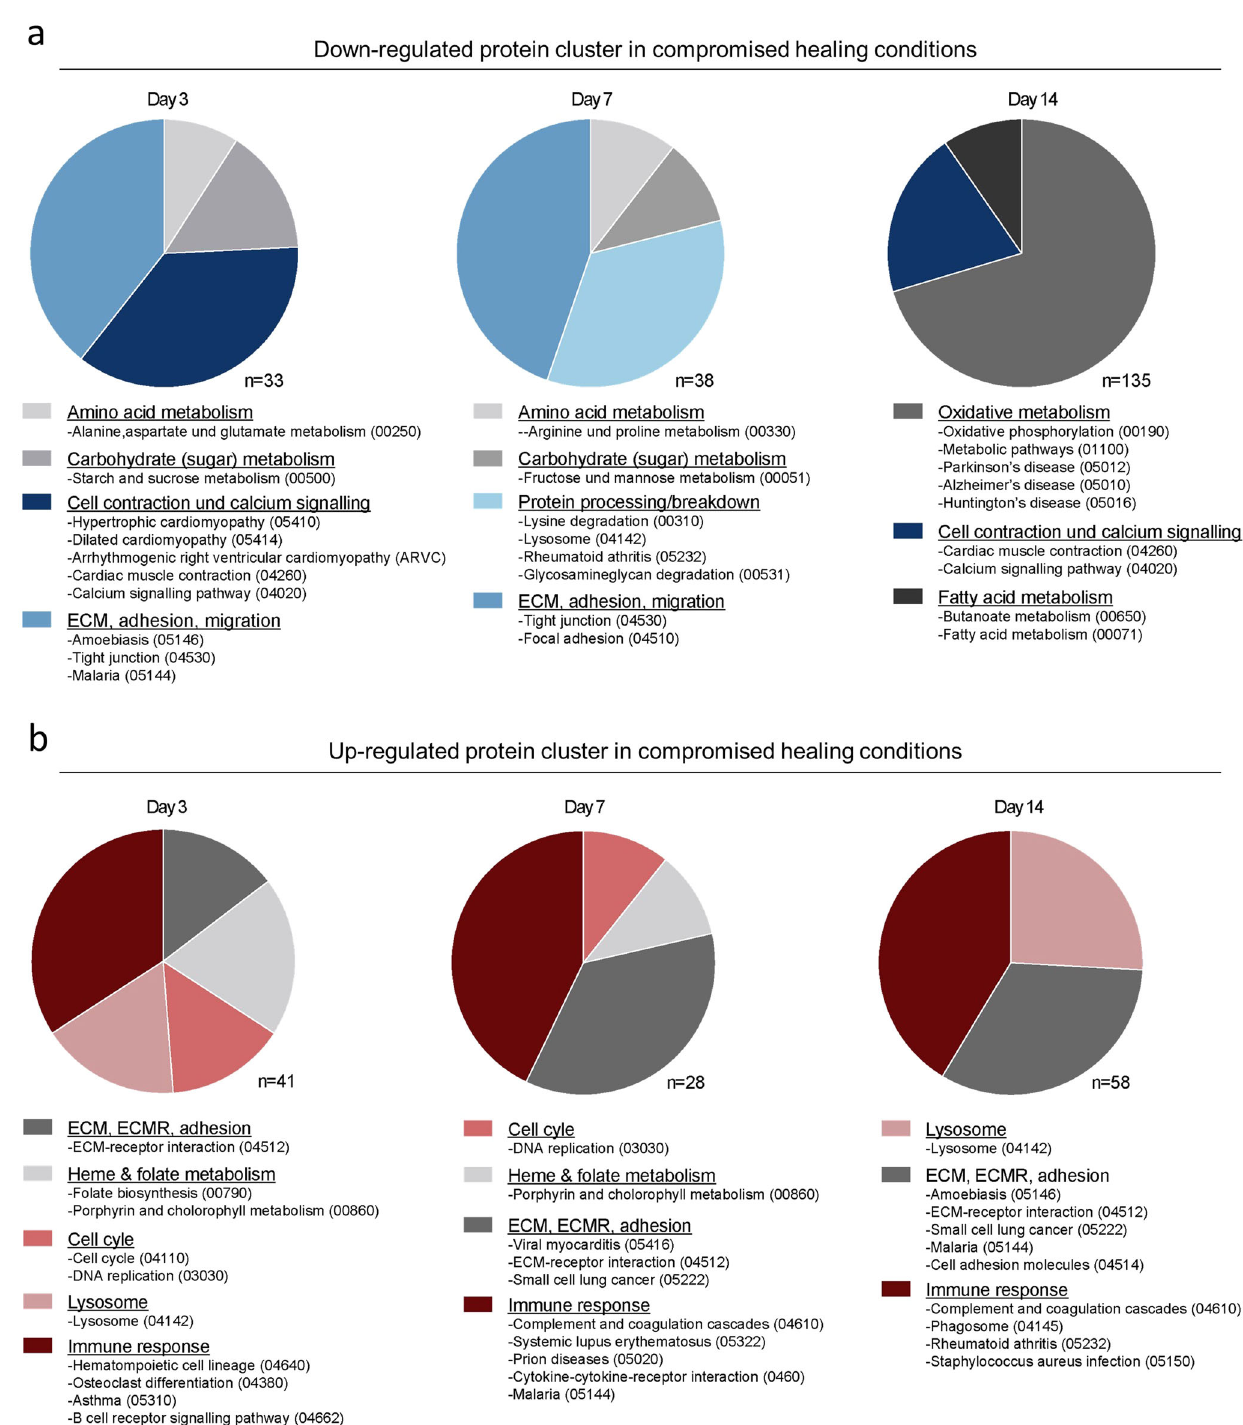
Fig. 3 GO and KEGG enrichment analyses of the fracture proteome reveal distinct differences in metabolic-, immune- and matrix-related processes between successful and compromised bone healing in rats. a Down-regulated pathways and processes in compromised bone healing tissue are related to amino acid and carbohydrate metabolism and extracellular matrix at day 3 and day 7, while oxidative metabolism processes are downregulated at day 14. Cell contraction and calcium signaling proteins are downregulated at day 3 and day 14 in particular. Total protein number ( n ) as identi fi ed by GO and KEGG enrichment analyses are indicated for each timepoint. b Protein cluster associated with immune responses and extracellular matrix — receptor interactions have been found up-regulated in compromised healing for all time points, while cell cycle proteins were upregulated at day 3 and 7 and lysosomal proteins increased at day 3 and day 14. Total protein number ( n ) as identi fi ed by GO and KEGG enrichment analyses are indicated for each